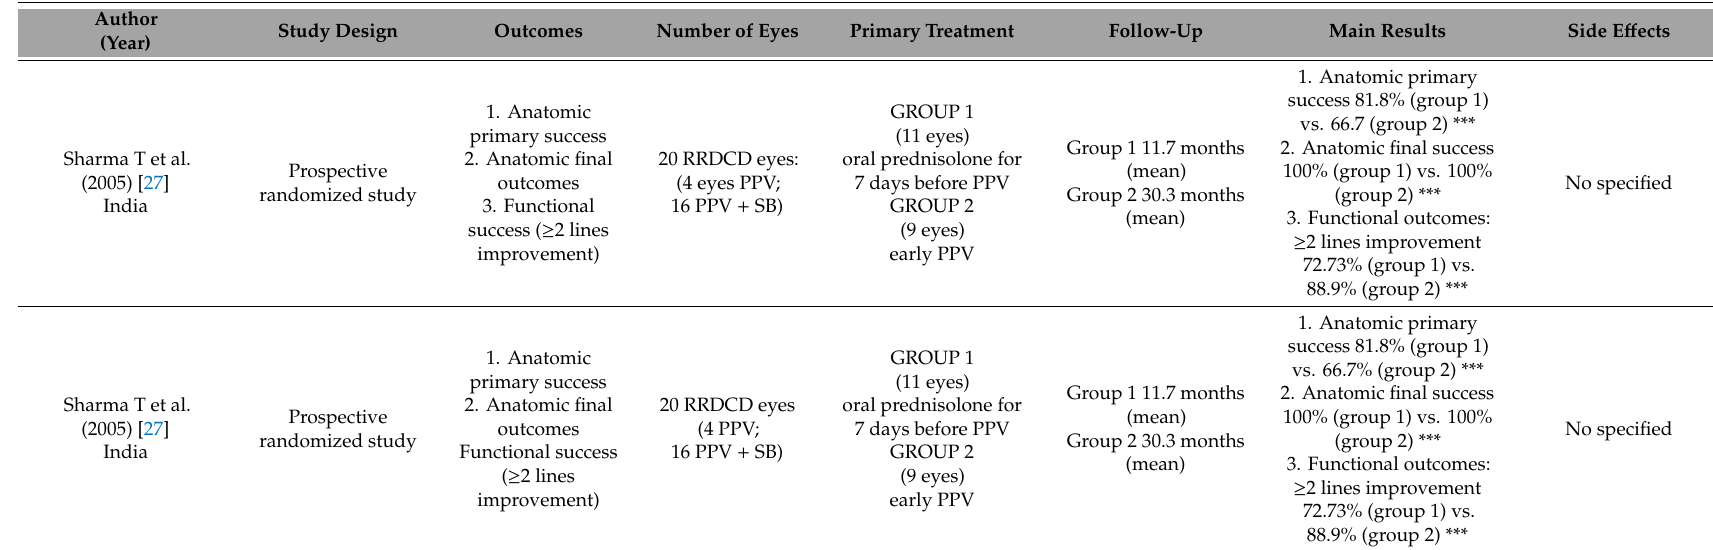
Table 1. Preoperative use of corticosteroid drugs in retinal detachment